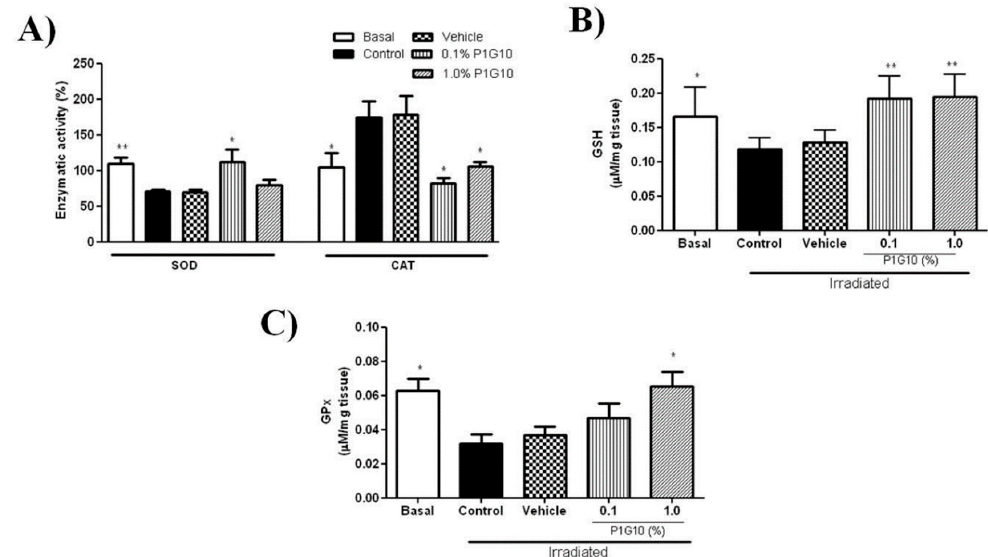
Figure 4. Effect of P1G10 on the activity of SOD, CAT, MPO, and GSH in UVB-irradiated skin. Mice were exposed to a single UVB dose (2.4 J cm − 1 ) followed by treatment with Natrosol gel (vehicle) or P1G10 (0.1% and 1.0%). Skin of euthanized mice was collected 24 h after irradiation and processed for analysis ( A ) SOD, CAT, ( B ) GSH and ( C ) glutathione peroxidase (GSH-Px). For details see Materials and Methods. Results represent the mean ± SEM of 6–8 animals per group (* p < 0.05 and ** p < 0.001 difference versus vehicle, ANOVA, Newman–Keuls post-test).